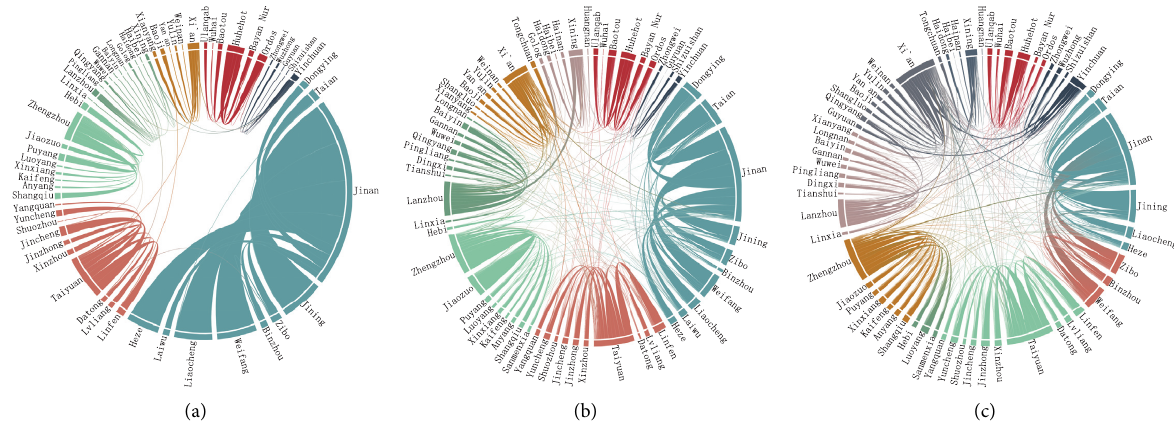
Figure 3: Evolution of urban network structure in the Yellow River Basin. (a) 2000. (b) 2010. (c) 2020.